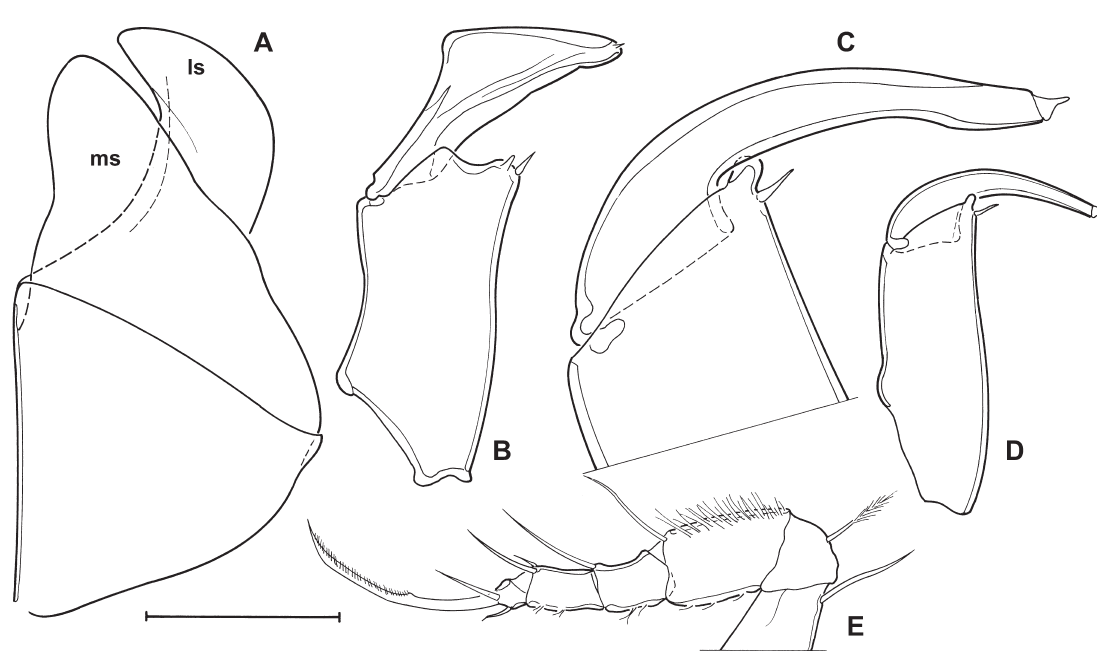
Fig. 11. Bennelongia frumenta sp. nov. (all allotype ♂, WAM.C49381, Kodjinup Melaleuca, type locality). A . Outline of hemipenis. B . right prehensile palp. C . Left prehensile palp, detail of distal part. D . Left prehensile palp. E . T2 (walking leg). Scales: E = 232 µm; A-C= 92 µm; D = 37